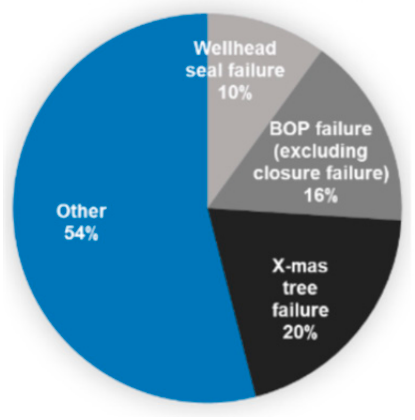
Figure 2. Causes of secondary barrier failure in 156 loss of well control events occurred during 2000– 2015.